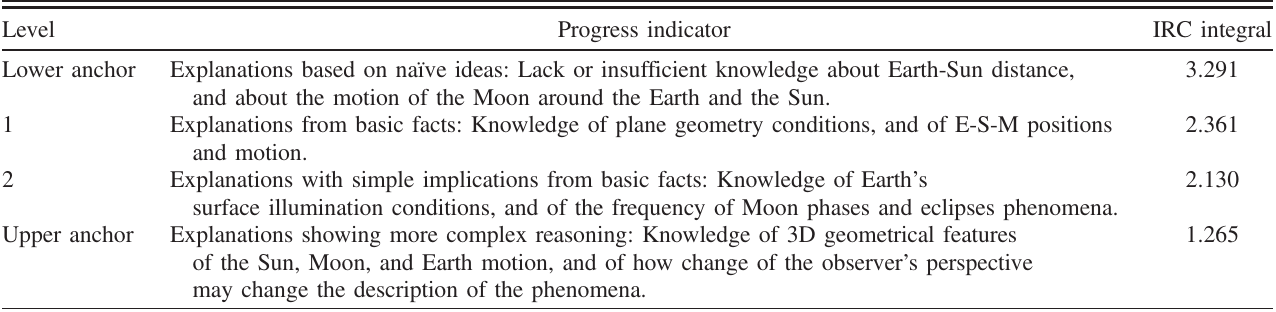
TABLE VII. Learning progression about Celestial Motion. Level Progress indicator Lower